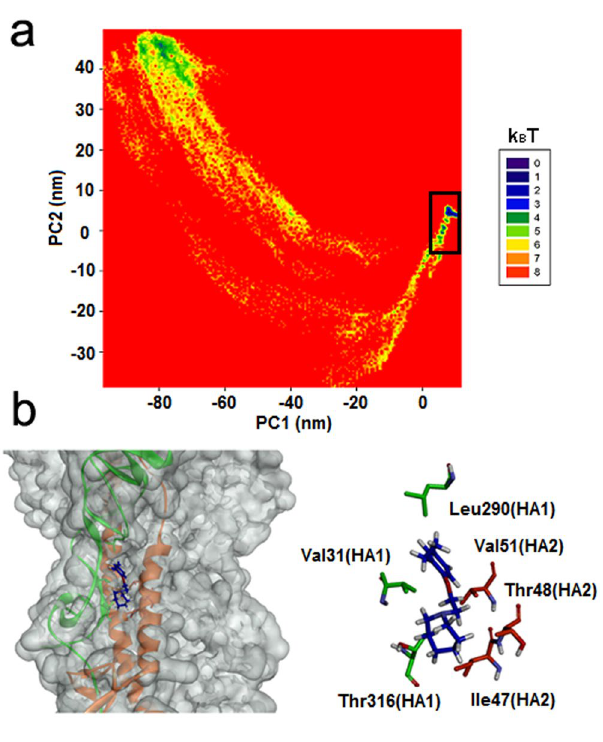
Figure 4. ( a ) Relative free energy surfaces along the first two principle components (PC-1, PC-2) of INT-HA under neutral conditions. ( b ) Predicted binding modes of INT-HA under neutral